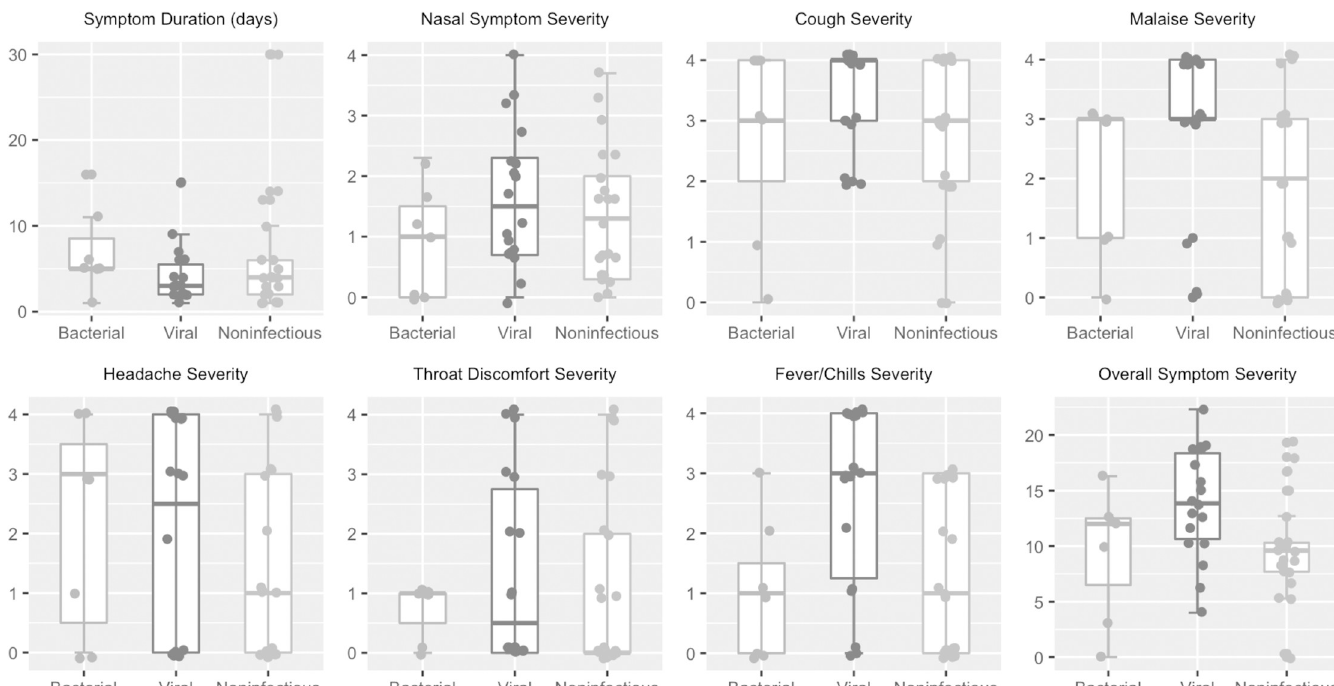
Fig 2. Symptom scores across clinically adjudicated phenotypes. Illness duration and symptom scores from each subject were compared between the different clinically adjudicated phenotypes. Symptom scores were graded on a 0 to 4 scale, with 0 indicating not present and 4 indicating “very severe”. Nasal symptoms represented an average of nasal discharge, nasal stuffiness, and sneezing. Overall symptom severity was simply the sum of all symptom scores. Most symptoms were similar between groups. Only two reached statistical significance: fever/chills (p = 0.005) and a composite of overall symptom severity (p = 0.02). Kruskal-Wallis statistical test was used to assess